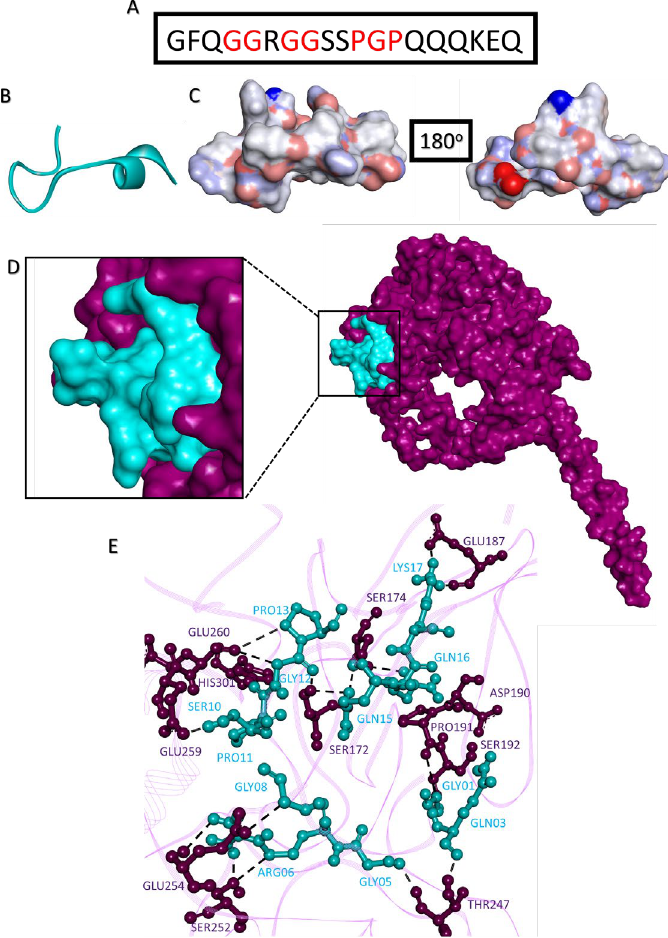
Figure 10. Disruptor peptide for the c-MYC-USP37 complex. ( A ) Primary sequence of designed disruptor peptide. Structure of disruptor peptide in ( B ) ribbon configuration and ( C ) electrostatic surface topology with 180° rotated view. ( D ) Surface topology of molecular complex between c-MYC (purple) and disruptor peptide (aqua); the interaction regions have been shown in the magnified inset. ( E ) Ball and stick representation of intermolecular interactions between amino acids of c-MYC (purple) and disruptor peptide (aqua), where dotted lines represent intermolecular hydrogen bonds.